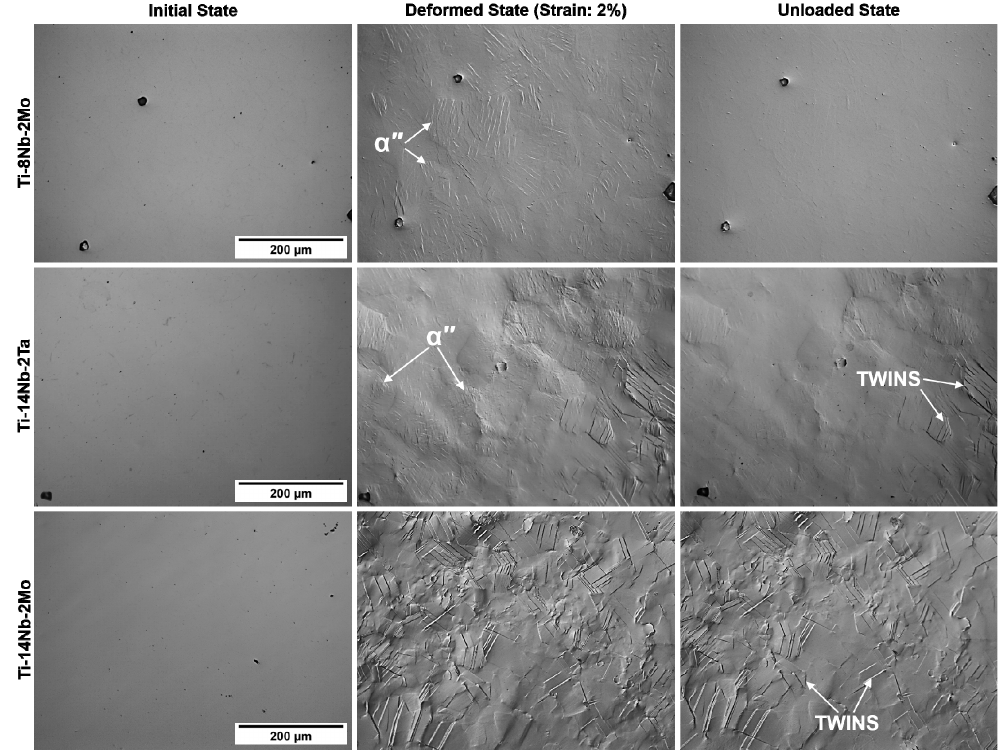
Figure 7. The OM microstructures of the investigated materials in the initial state, deformed to ε = 2% and when the stress was removed (unloaded state).